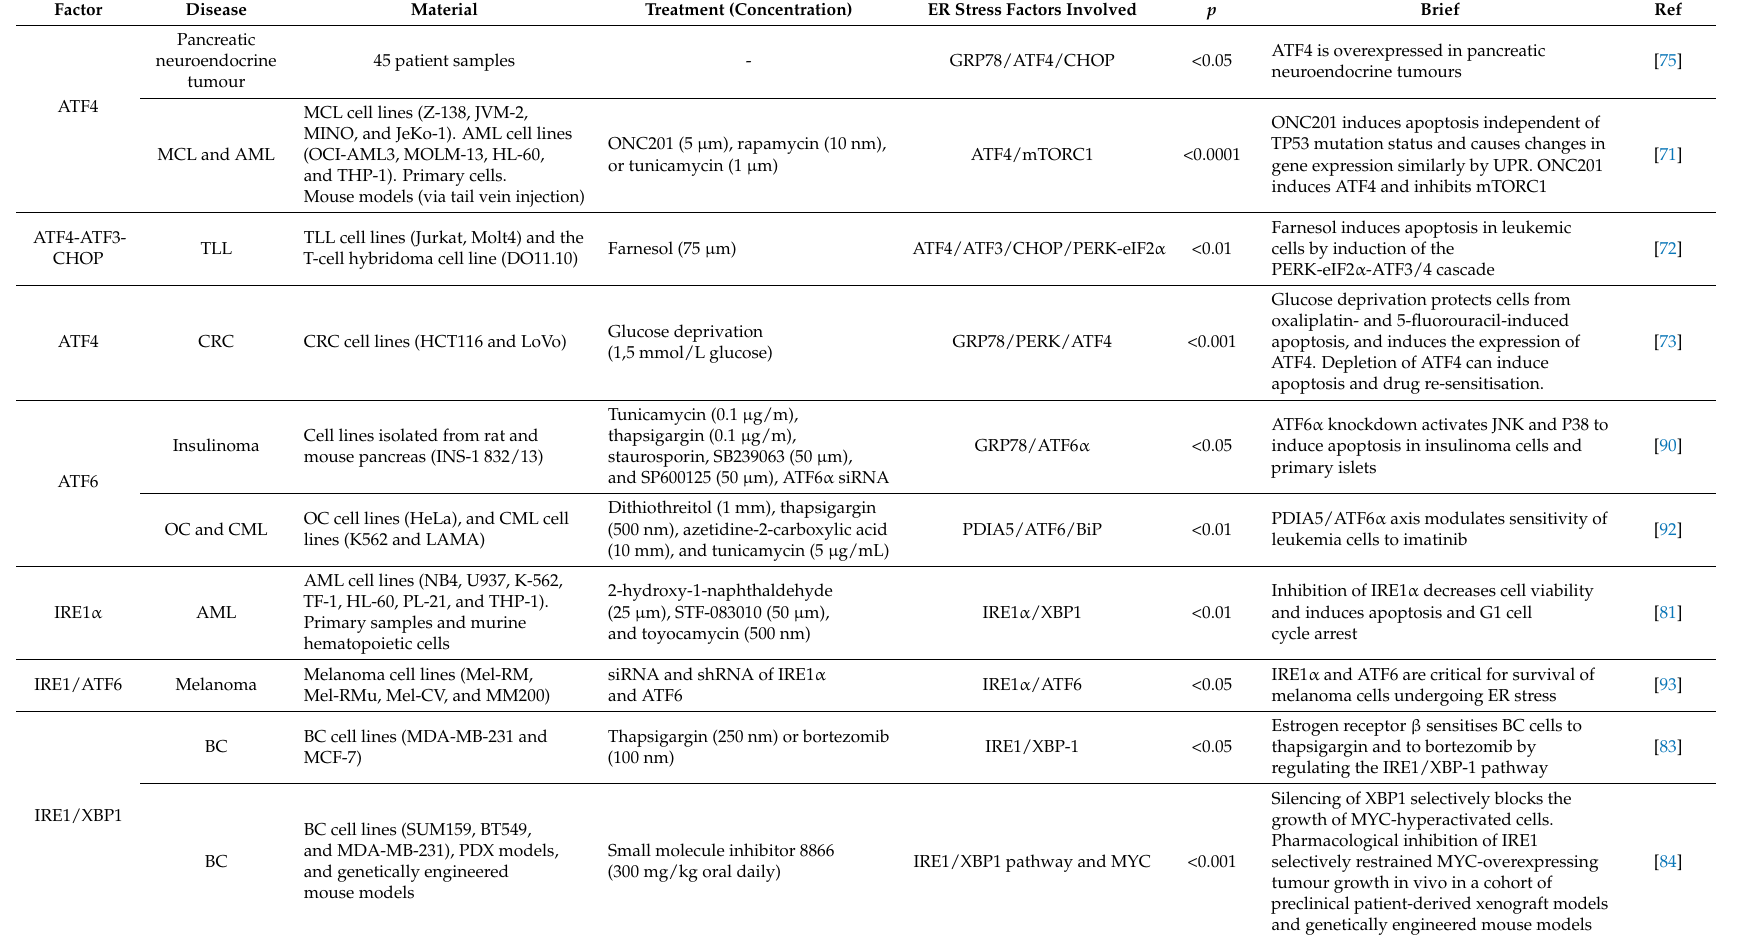
Table 2. Pre-clinical studies with ER stress response factors in other solid tumours and haematological